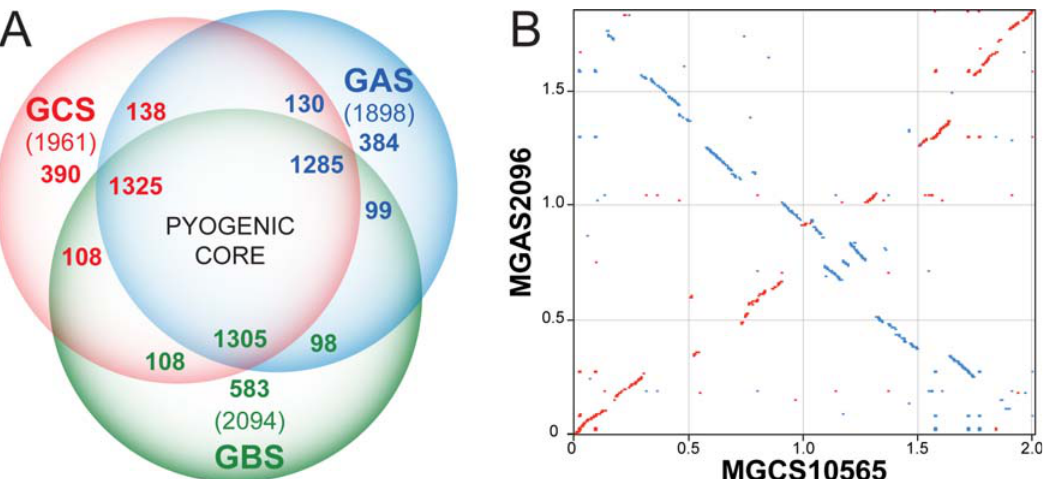
Figure 3. Genome comparisons. ( A ) Gene content comparison . The inferred proteomes of S. zooepidemicus (GCS), GAS, and S. agalactiae (GBS) were compared pair wise to the translated genomes of each other using TBLASTN (cutoff, e =10 2 9 ). The numbers of genes given for each section are color coded to match the respective genomes. The numbers for CDS shared in common in the intersections differ slightly due to variance in gene copies species-to-species, such as resulting from gene duplication and mobile genetic element transfer events. ( B ) Aligned GCS and GAS genomes. The nucleotide sequence of the MGCS10565 (GCS) and MGAS2096 (GAS) genomes were compared and regions sharing at least 60% identity over a window of 30 nucleotides are illustrated. Conserved regions oriented in the same direction are in red, and regions opposite in direction are in blue.